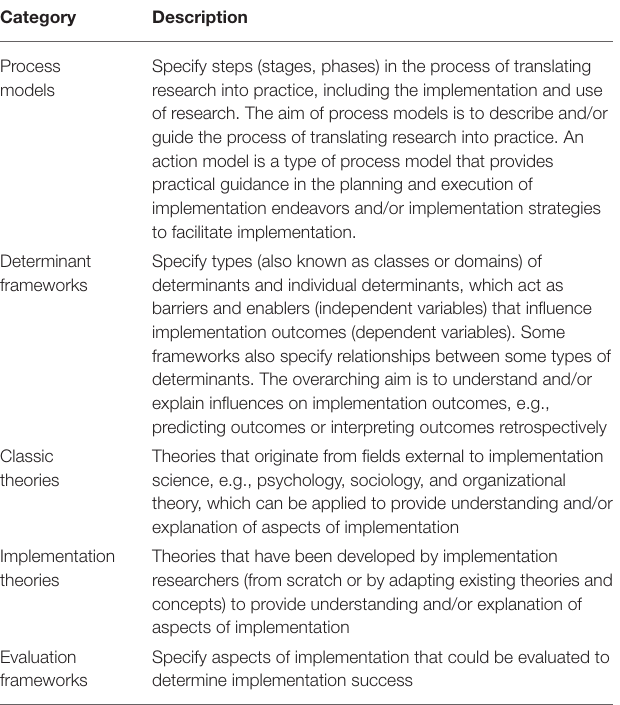
TABLE 2 | Five categories of theories, models and frameworks used in implementation science.